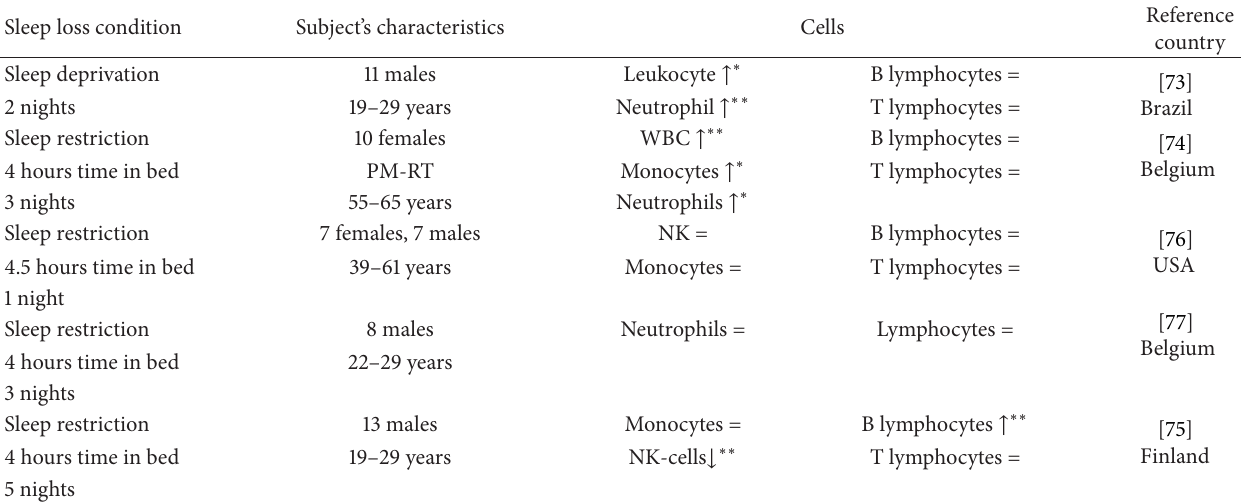
Table 2: Sleep loss effects on immune cellular components in